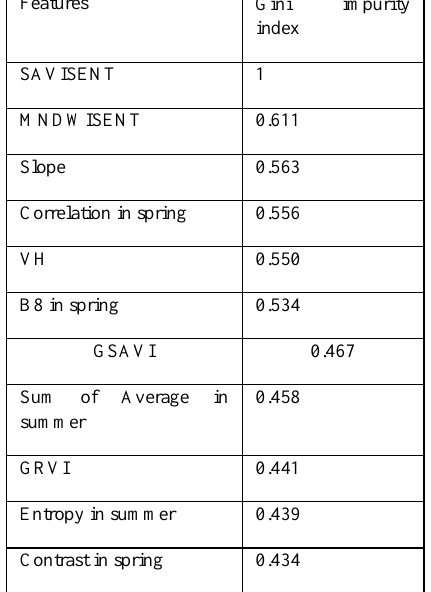
Table 2. The mean decreases in Gini impurity index for the first eleven important features.